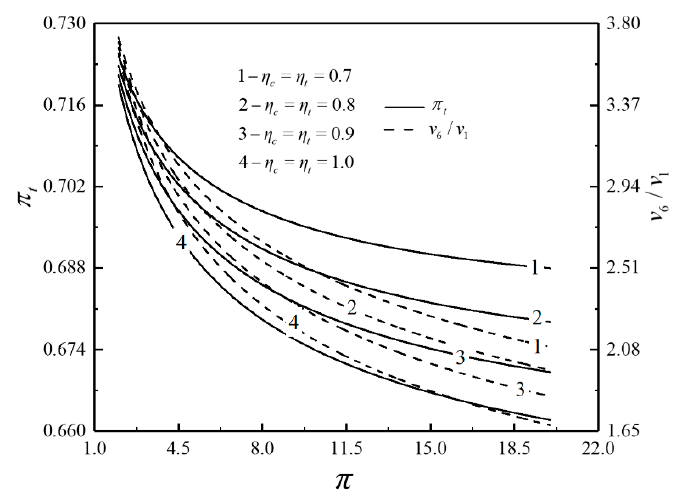
π with different c η and t η .